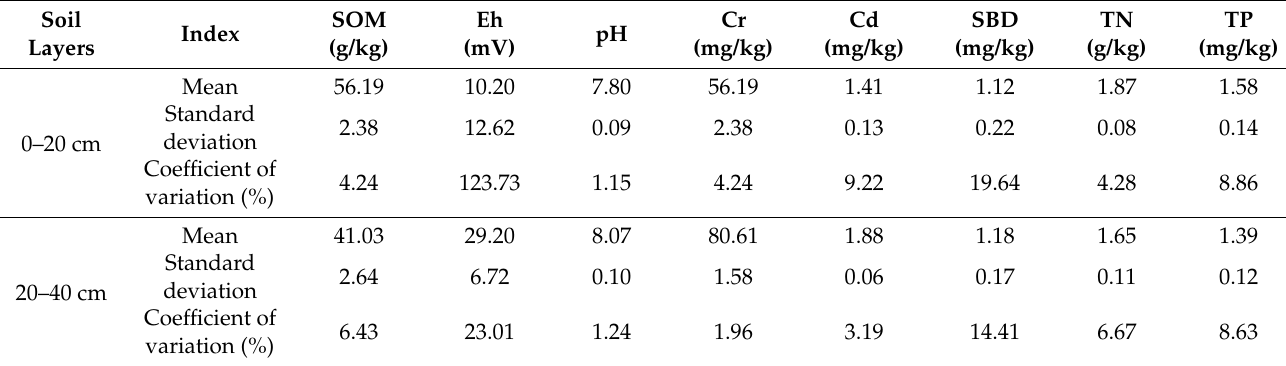
Table 1. General information of sampled